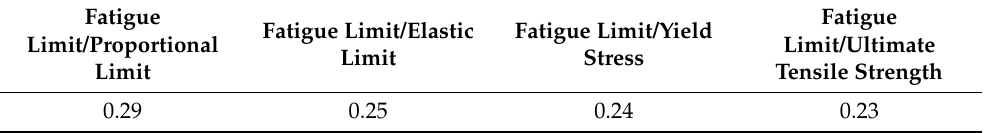
Table 8. Stress and number of cycles from the fatigue test of the Hardox 450 welded in MAG.